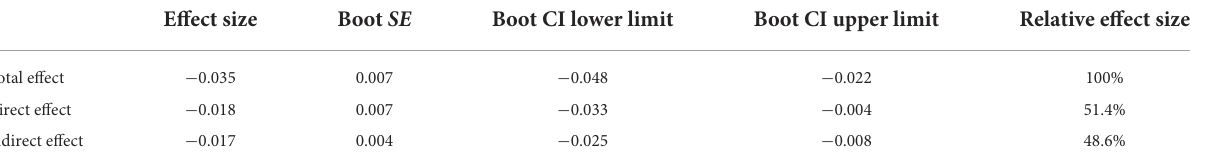
TABLE 4 Direct and indirect effects of sleep quality on creativity.